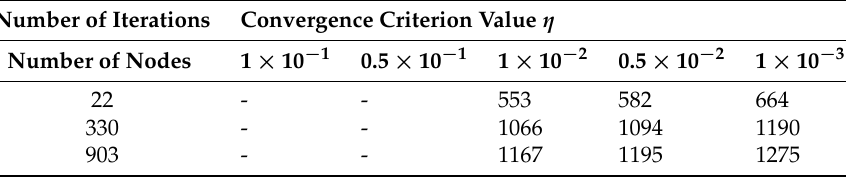
Table 3. Number of iterations until convergence (blank values denote no